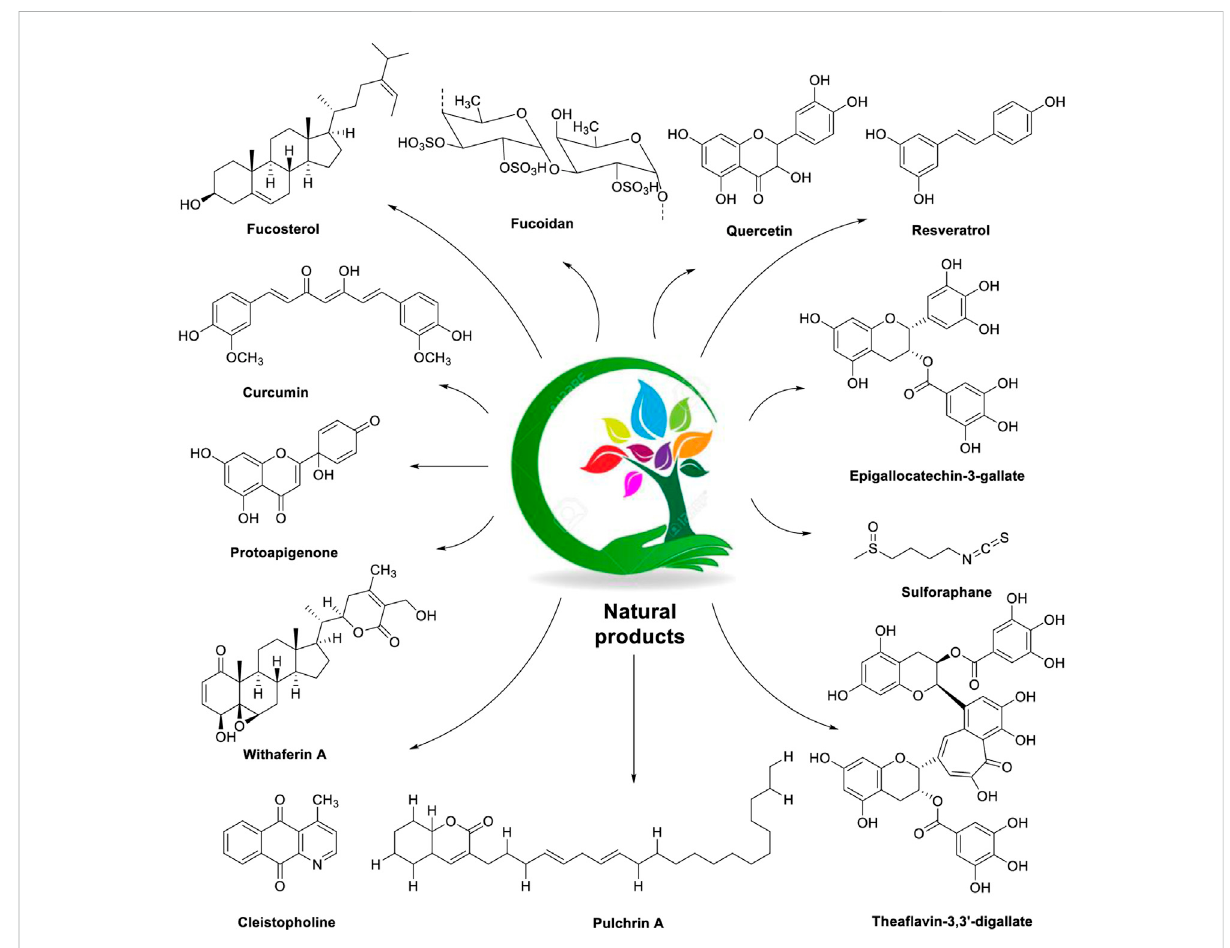
FIGURE 2 Chemical structures of natural products (fucosterol, fucoidan, quercetin, resveratrol, curcumin, protoapigenone, epigallocatechin-3-gallate, sulforaphane, withaferin-A, cleistopholine, pulchrin A, and thea fl avin-3,3 ′ -digallate) used in the management of ovarian cancer with a focus on the ER stress